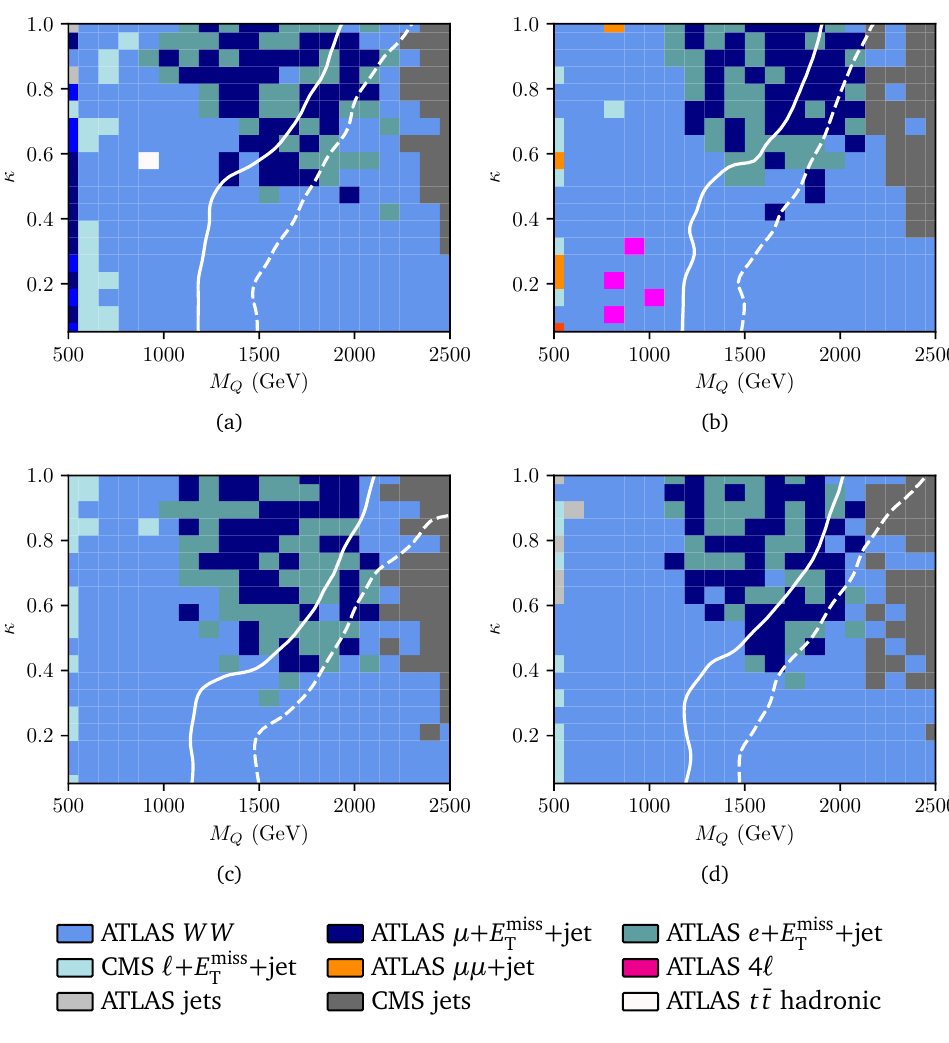
Figure 10: Dominant LHC analysis pools contributing to VLQ limit-setting in the κ vs VLQ mass plane, where κ is the coupling to third-generation SM quarks. All VLQ ( B , T , X , Y ) masses are set to be degenerate. The disfavoured regions are located above and to the left of the dashed (68% CL) and solid (95% CL) white contours respectively. The VLQ branching fractions to W : Z : H are (a) 0:0:1 (b) 0:1:0 (c) 1:0:0 and (d) 1 : 1 : 1 2 4 4